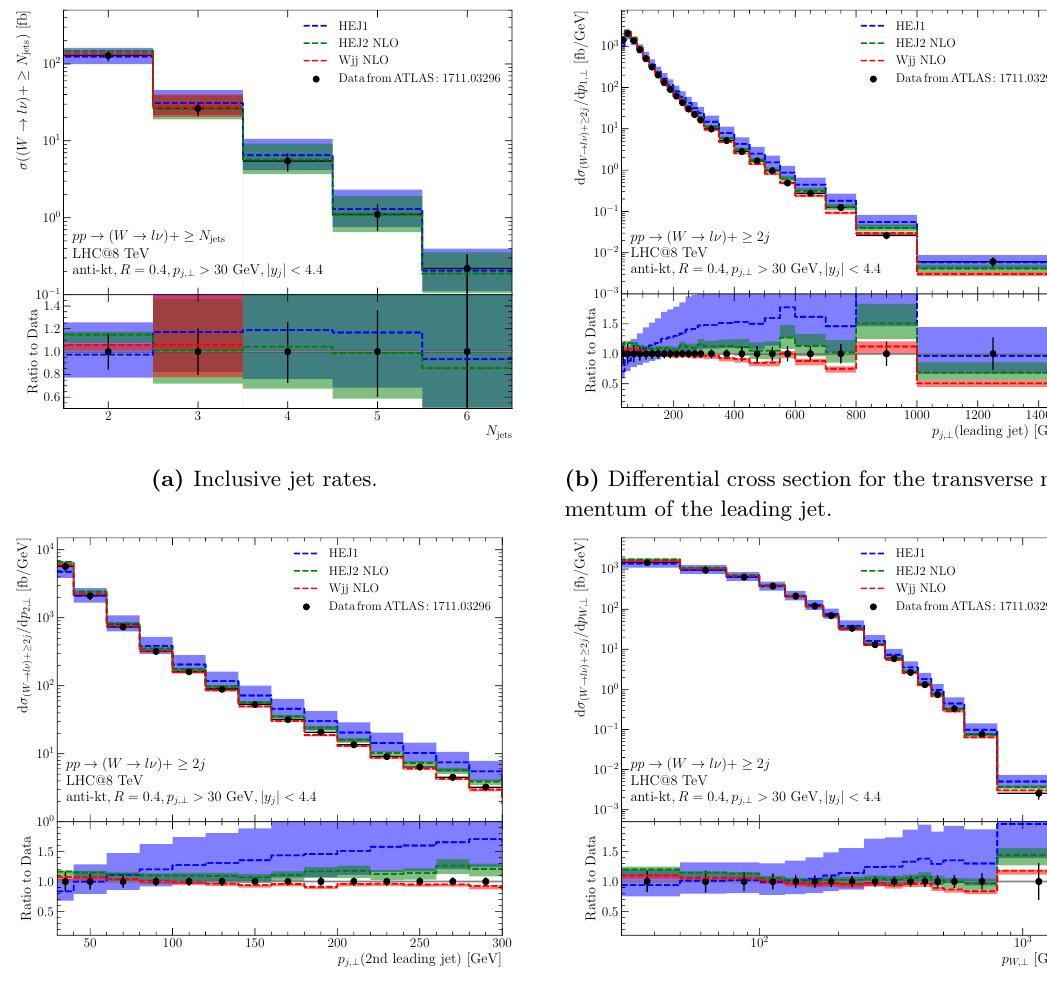
(d) Differential cross section for the transverse mo- mentum of the boson.